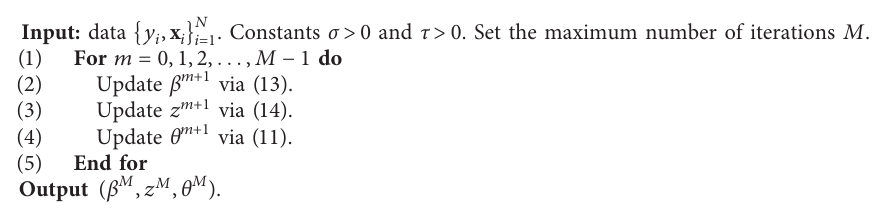
-penalized quantile 1